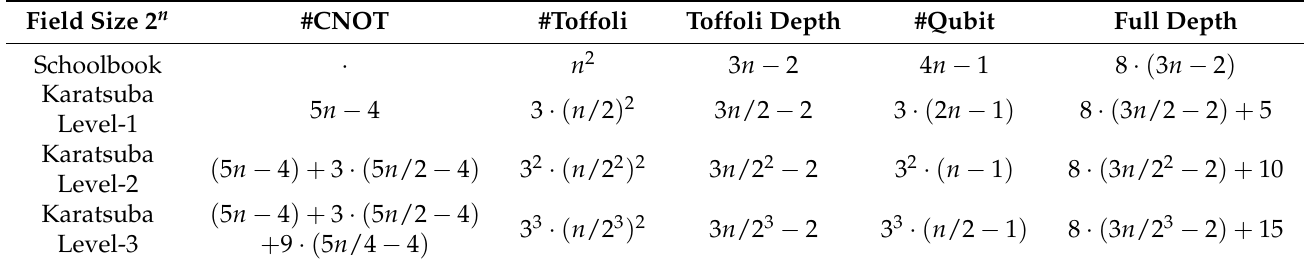
Table 1. Quantum resources required for multiplication at each Karatsuba